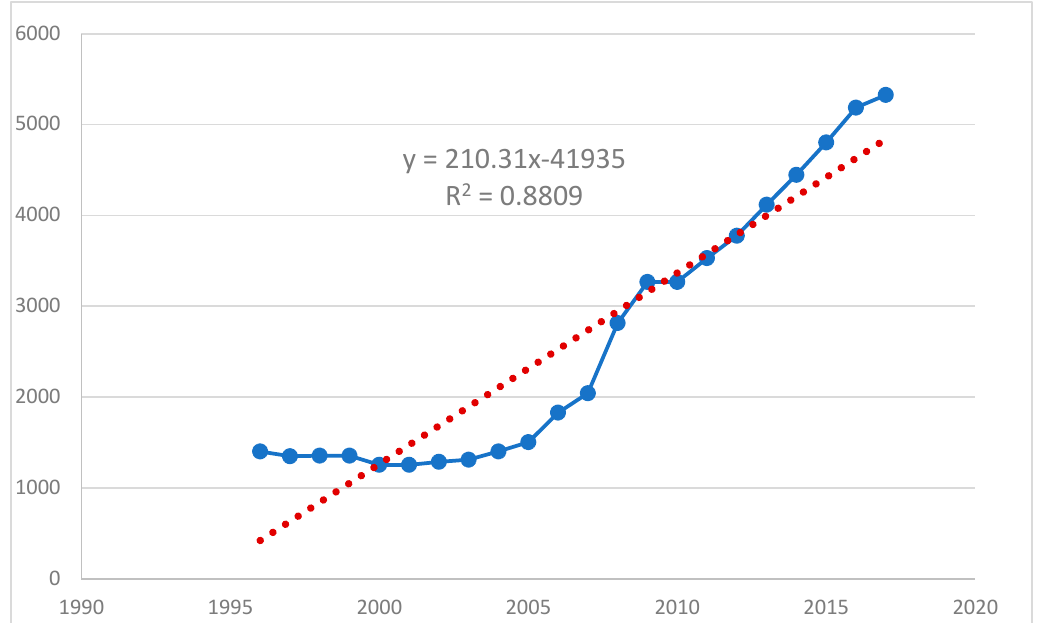
Figure 2. Trend analysis plot for yam output in Cross River State. Source: Author’s computation from data obtained from NPAFS and FMW&WR.